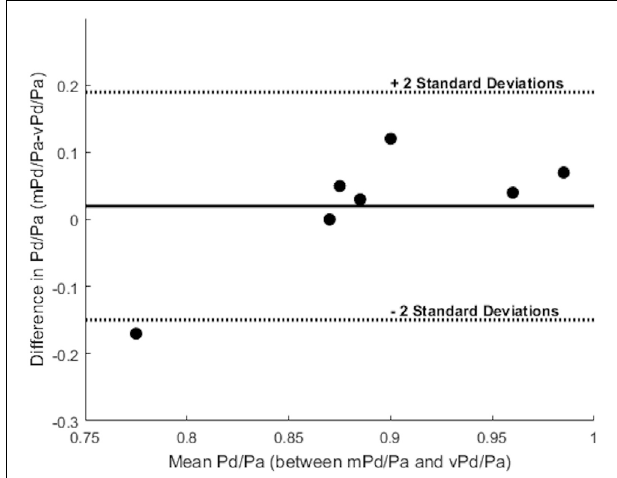
FIGURE 7 | Bland Altman plot. The solid line represents the mean value of the difference between mPd/Pa and vPd/Pa, and the dotted lines create boundaries for ± 2 standard deviations from the mean difference. Each dot represents a stenosis and combines the knowledge for the difference and the mean value between the measured and the virtual calculations.